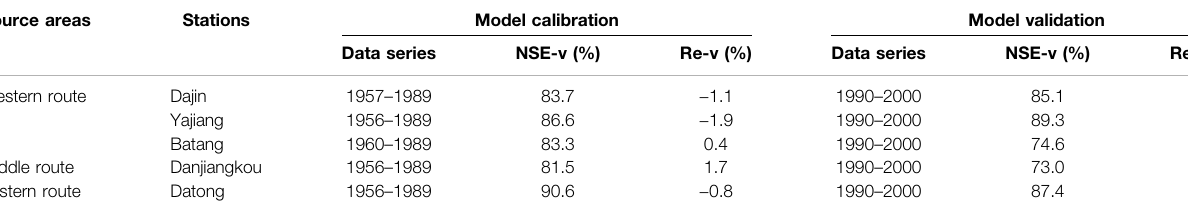
TABLE 2 | Discharge simulation results for the fi ve hydrometric stations within source areas of the South-to-North Water Diversion Project. Source areas